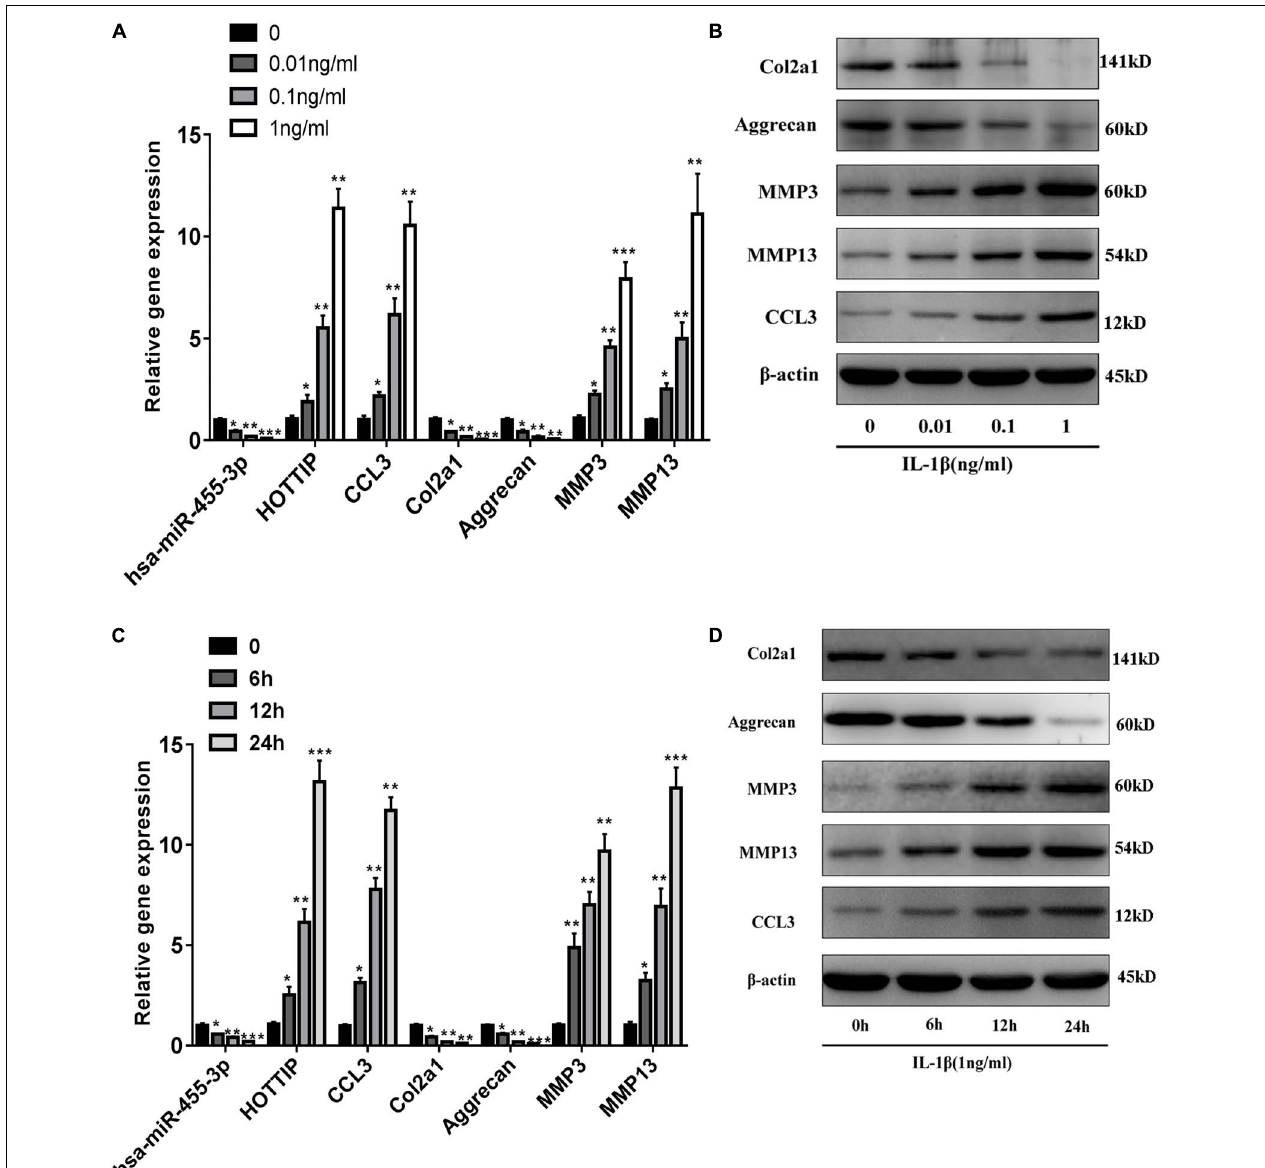
FIGURE 5 | Expression of miR-455-3p, HOTTIP and CCL3 in IL-1 β -stimulated human primary chondrocytes and an inverse correlation between IL-1 β -regulated HOTTIP, CCL3 and miR-455-3p expression in PHCs. PHCs were deprived of serum for 6 h, and then left untreated or treated with various concentrations (0, 0.01, 0.1 and 1 ng/ml) of IL-1 β after 24 h (A) . The relative expression levels of gene and protein at 6 h, 12 h, or 24 h post-treatment with 1 ng/mL IL-1 β (C) . The relative expression levels of miR-455-3p) and HOTTIP (A,C) were assessed by RT-qPCR; While the expression levels of CCL3, Col2a1 Aggrecan, MMP3 and MMP13